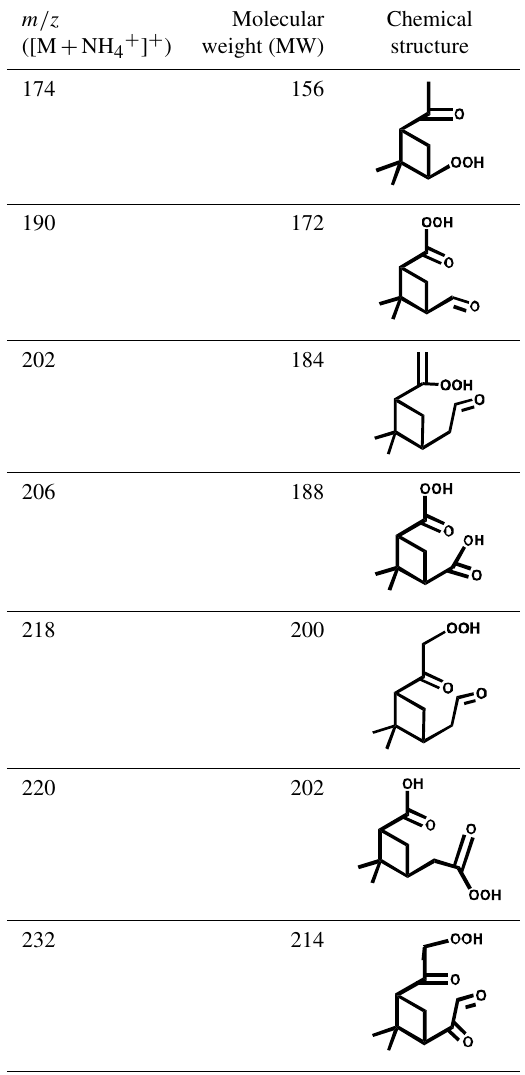
Table 1. Possible identities of the ROOH in α -pinene SOA.